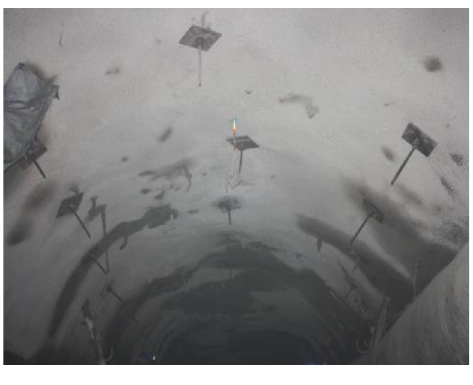
Figure 8: Grouting e ff ect.